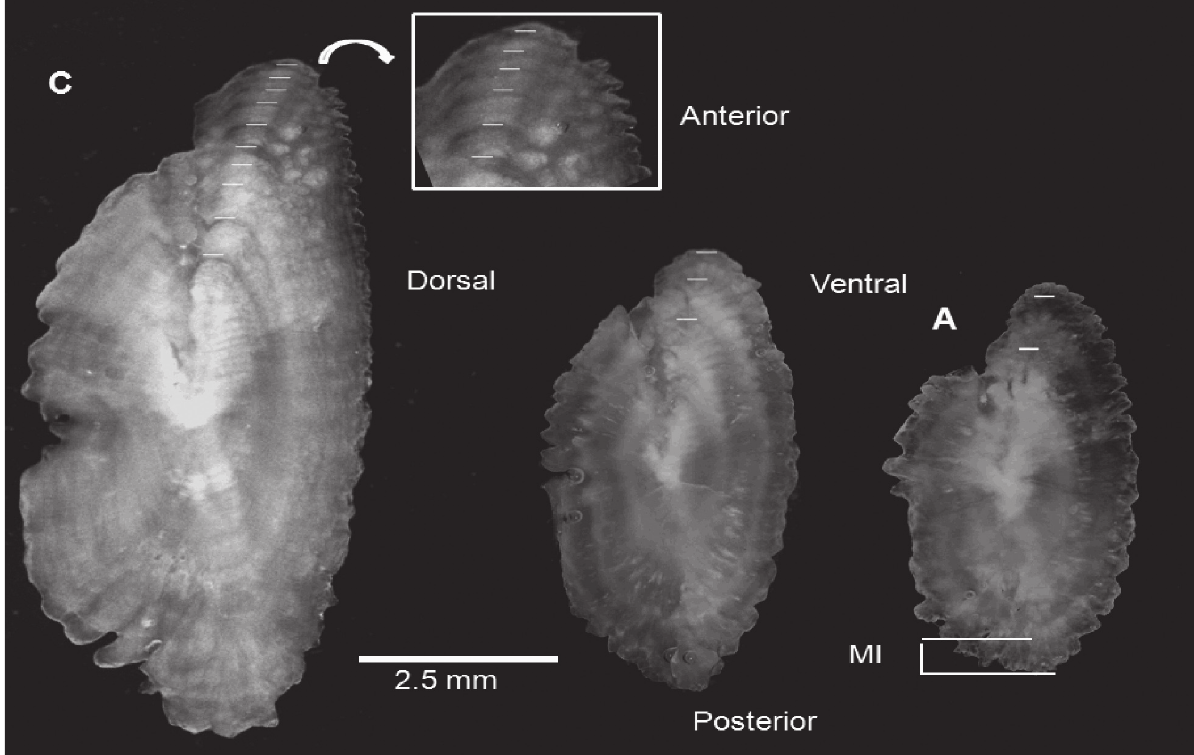
Fig. 3. – sagittal otoliths of Mycteroperca fusca off the canary Islands. a, a 2-year-old specimen (272 mm); B, a 3-year-old specimen (317 mm); and c, a 10-year-old specimen (521 mm). MI is the width of the marginal increment measured. annuli are represented at the outer margin of the translucent